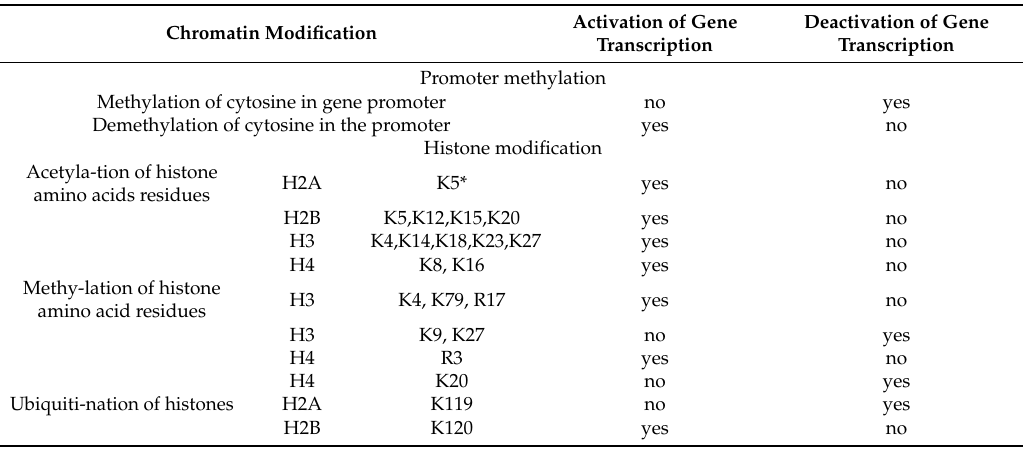
Table 2. Examples of the epigenetic changes of chromatin and their influence on gene activity (from [11],